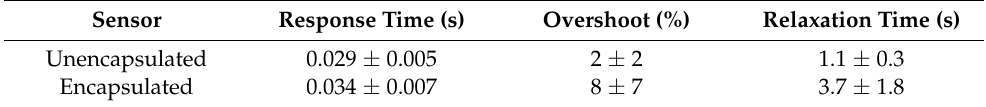
Figure 3. Representative schematic of segments used to determine response time, overshoot, and relaxation time of each sensor with segments based off a 90% time constant. All polymer-based strain sensors have a response delay due to the viscoelastic nature of the polymer. Table 1. Average reported latency values with standard deviation for unencapsulated and encapsulated sensors, respectively, with N = 6 for each category.